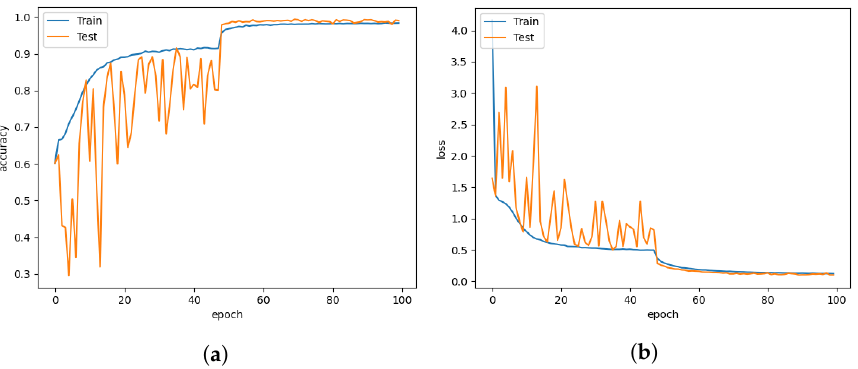
Figure 13. CNN-LeakyReLU for learning rate = 0.001. ( a ) Model accuracy. ( b ) Model loss.